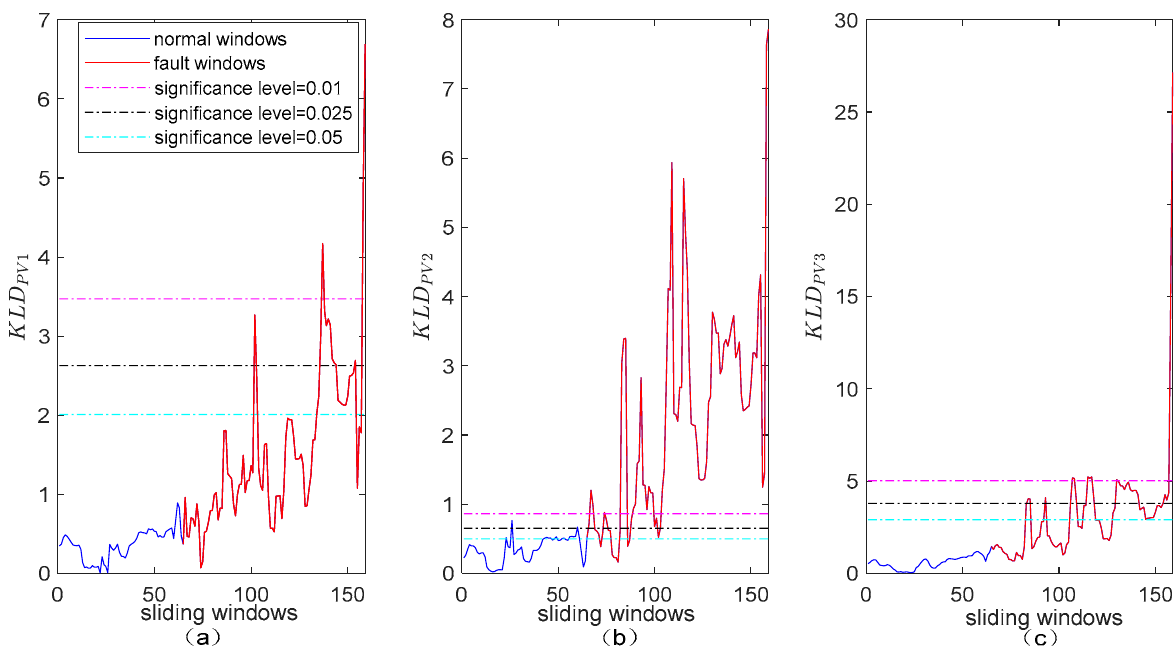
Figure 12. The results of detecting the spread-spectrum transponder fault by using the PCA + KLD1 method and the PCA + KLD2 method at different significance levels: ( a ) the result of first PV for the fault; ( b ) the result of second PV for the fault; ( c ) the result of third PV for the fault.